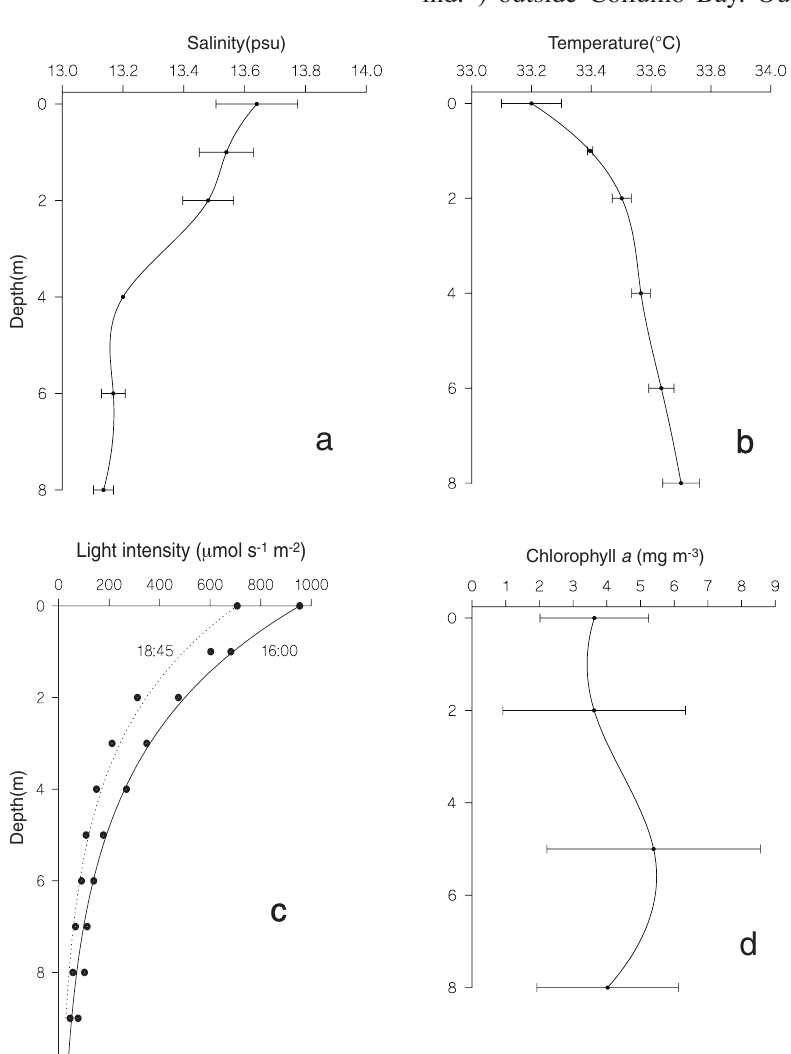
F IG . 2. – Vertical profiles of salinity (a), temperature (b), light penetration through the water column (c) and chlorophyll a (d) recorded in Coliumo Bay during the diel study (November 1996). In a, b and d error bars are standard